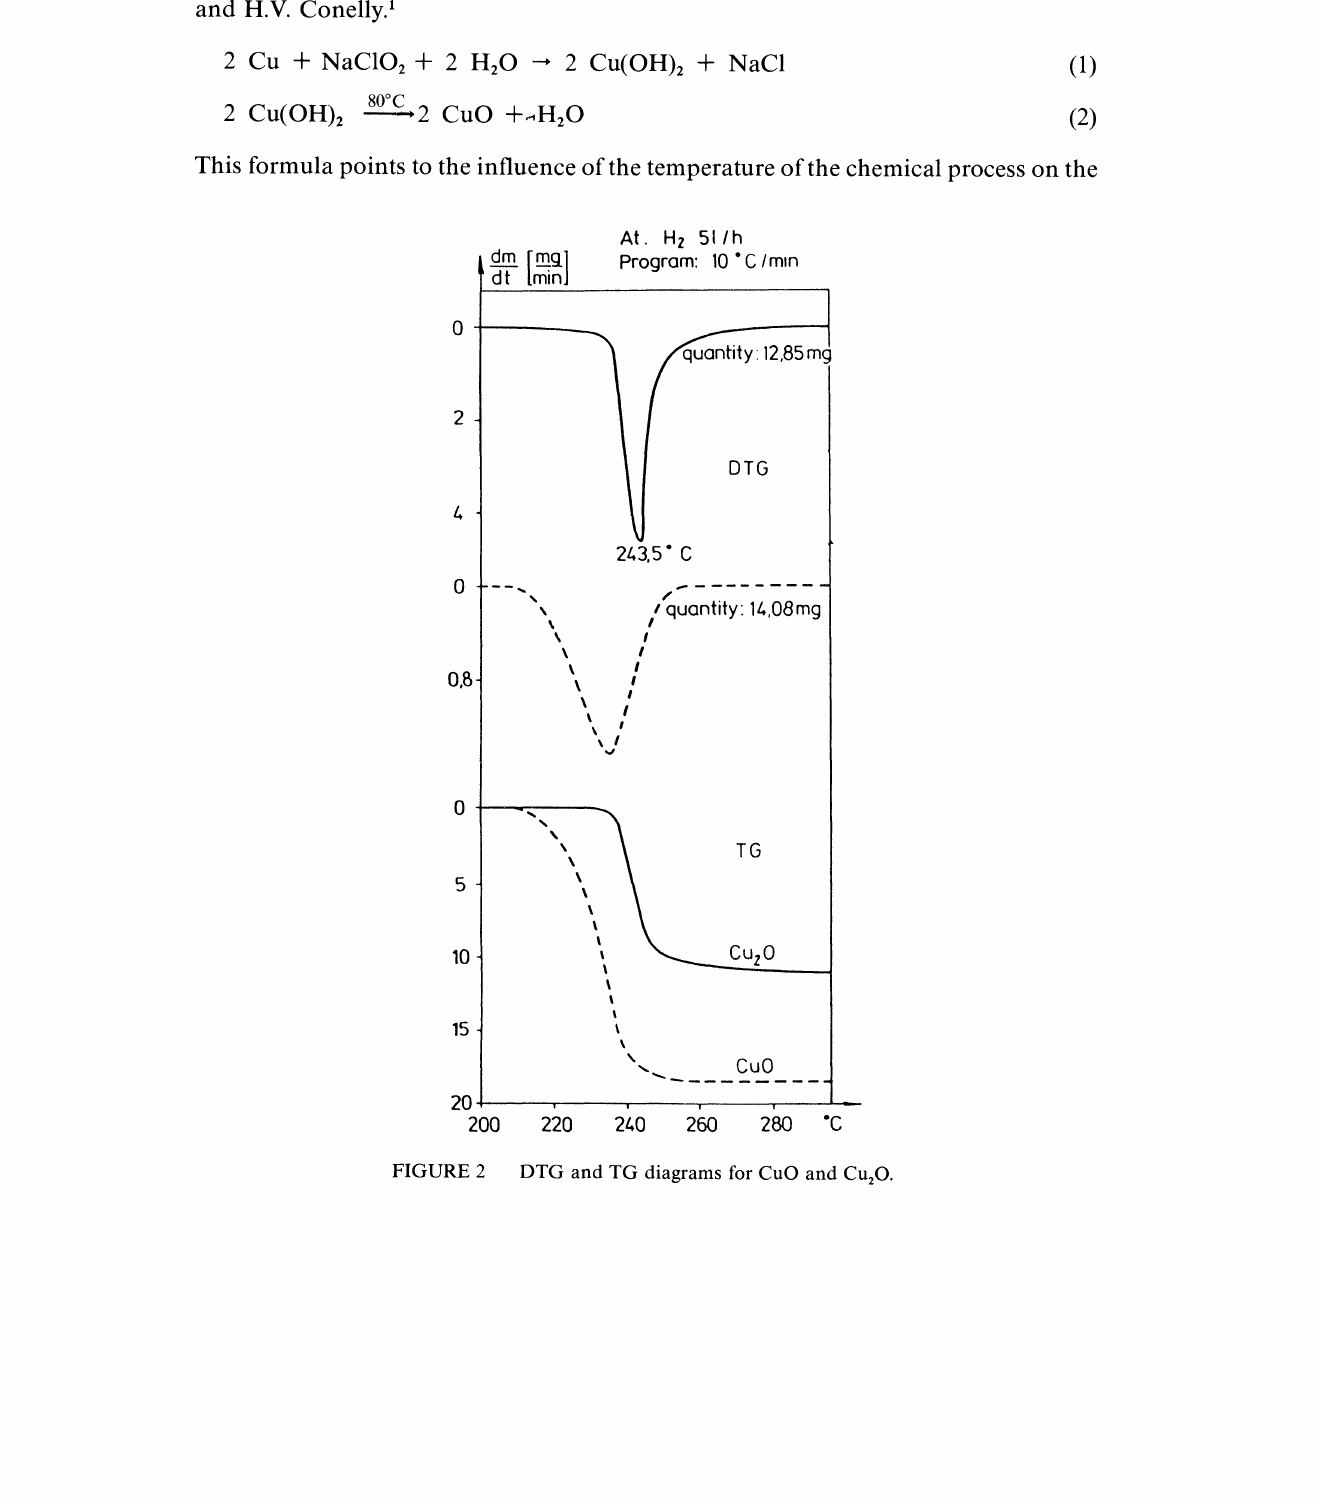
DTG and TG diagrams for CuO and